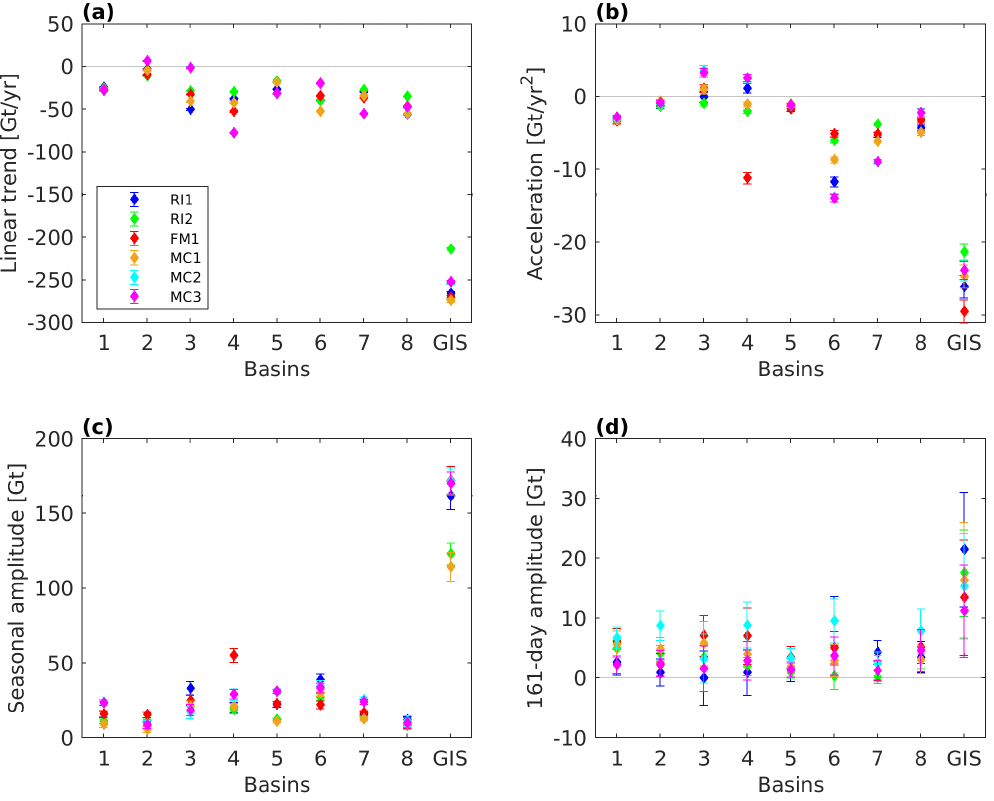
Figure 10. Temporal changes in ice mass for all GIS basins and aggregations, derived using a consistent linear, periodic (1yr, 1/2yr, 161/365.25yr) and quadratic model for all time series: ( a ) linear trend, ( b ) acceleration, ( c ) seasonal amplitude, ( d ) 161-day period, including the formal errors from the least squares